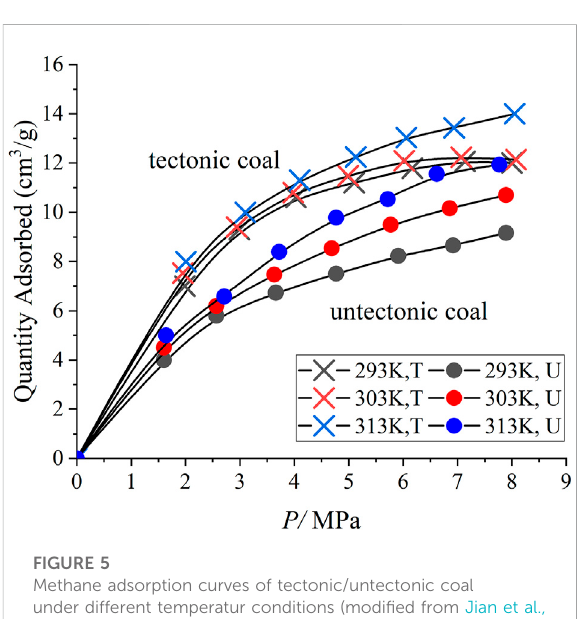
FIGURE 5 Methane adsorption curves of tectonic/untectonic coal under different temperatur conditions (modi fi ed from Jian et al.,